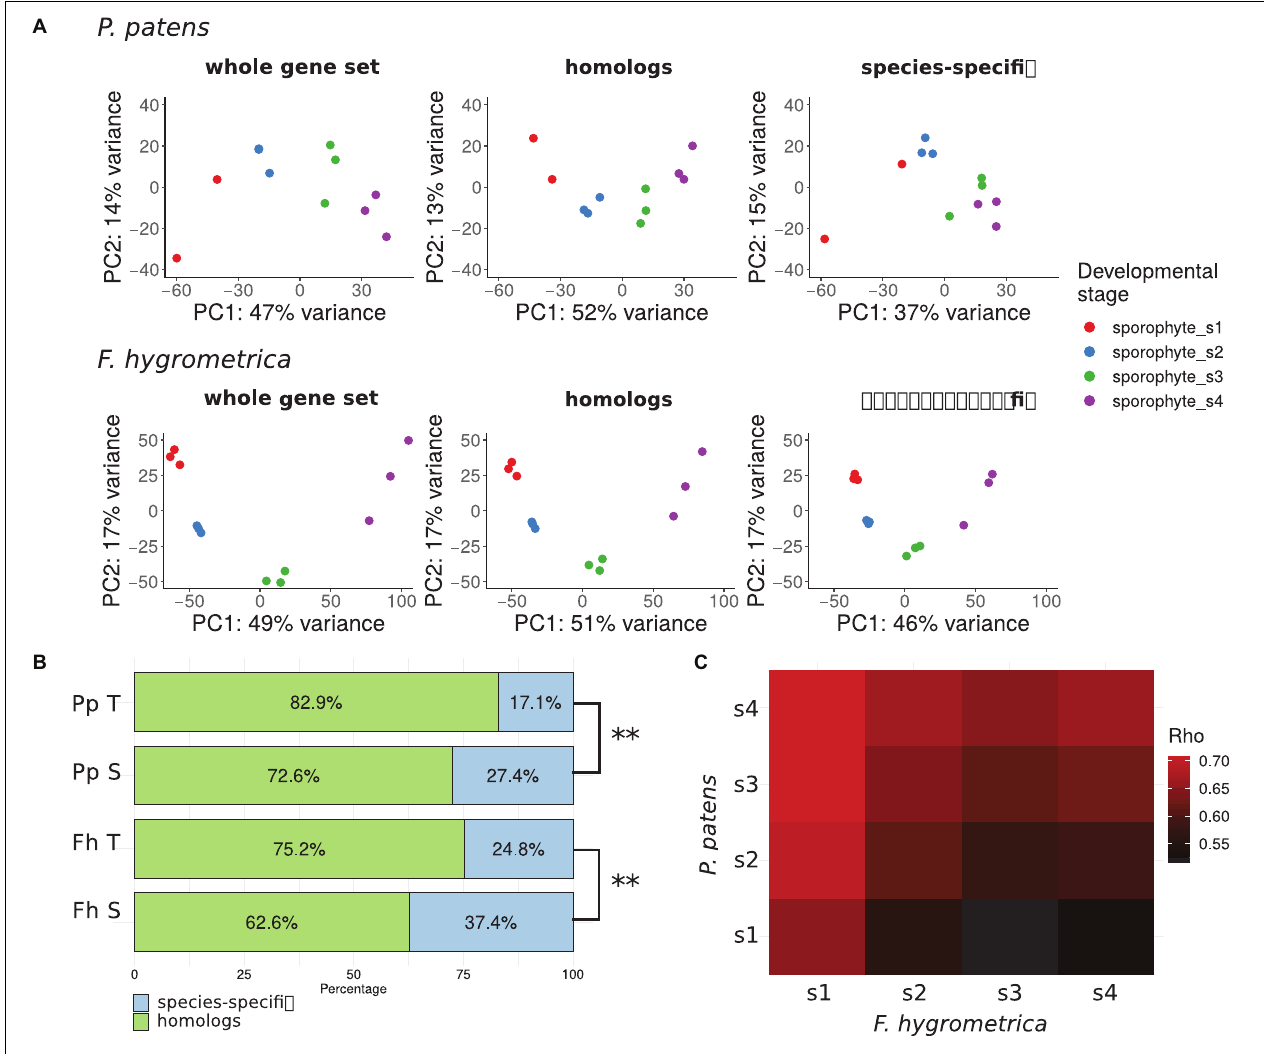
FIGURE 3 | Gene expression variation throughout the sporophyte development of Funaria hygrometrica and Physcomitrium patens . (A) Principal component analysis (PCA) of gene expression variation during sporophyte development in P. patens and F. hygrometrica . PCA was carried out by using gene expression data for all expressed genes (“whole gene set”), for homologous genes (“homologs”), and for species-specific genes (“species-specific”). (B) Proportion of homologous and species-specific genes in the transcriptome data sets of F. hygrometrica (Fh) and P. patens (Pp). For each species the total set of transcripts detected in the gametophyte and sporophyte phases (Pp T, Fh T) and the set of transcripts that is specifically expressed in the sporophyte phase (Pp S, Fh S; log 2 fold change ≥ 2, q ≤ 0.05) is shown. ∗∗ marks significant dependence of distribution between homologs and species-specific genes on the considered subset according to Chi-squared test ( p ≤ 0.01). (C) Correlation coefficients (Spearman’s Rho) of gene expression between developmental stages 1 to 4 of P. patens and F. hygrometrica sporophytes. Only one-to-one orthologs for which expression was observed in both samples were used to calculate the corresponding rank correlation. Spearman’s Rho was calculated using normalized and log-transformed raw count